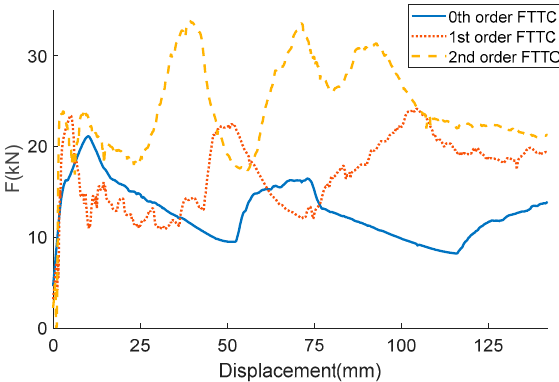
Figure 9. Force–displacement curves of different FTTC columns.